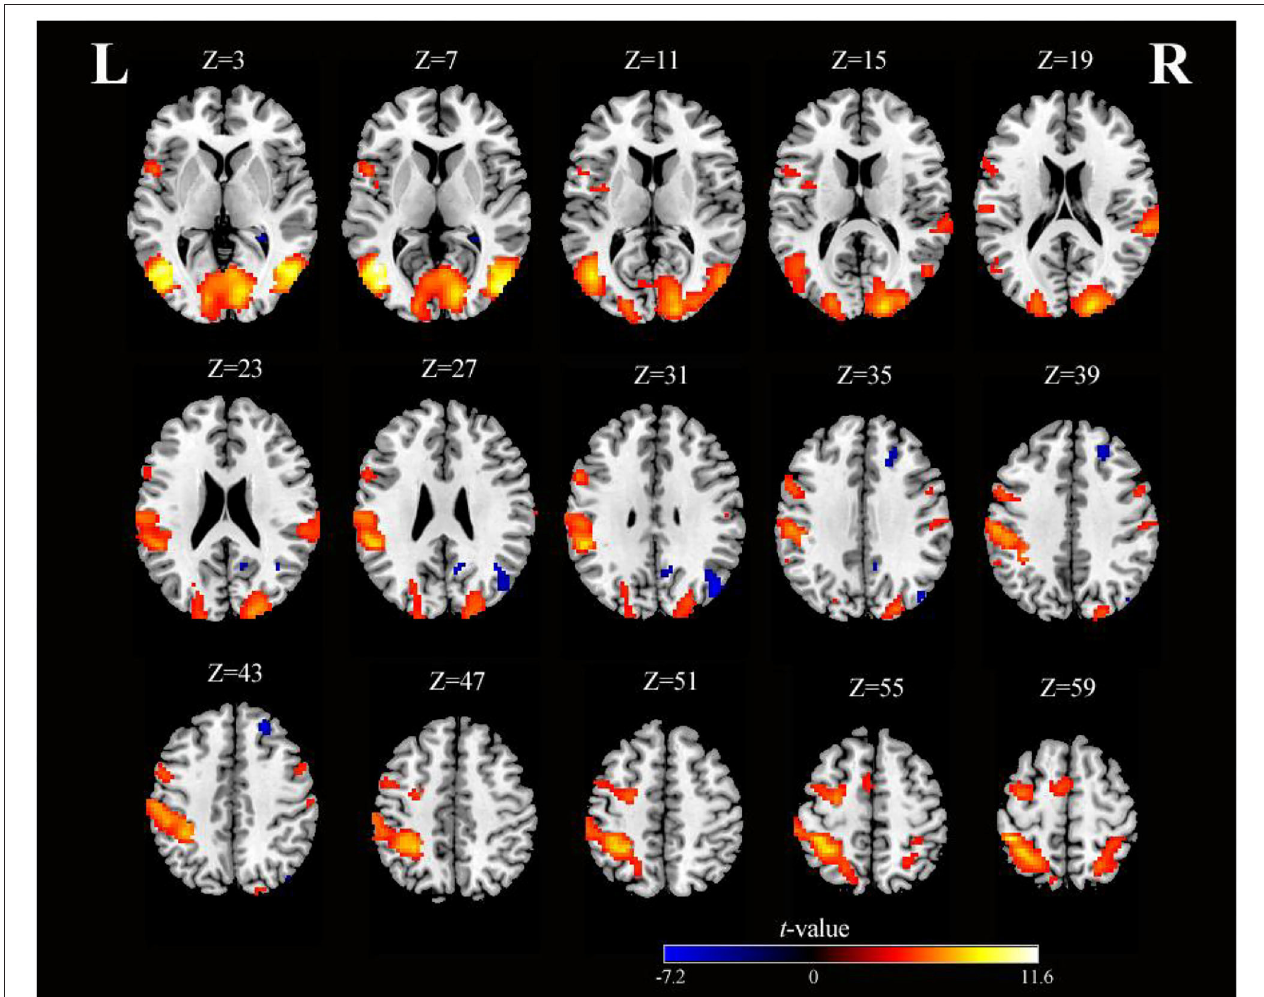
FIGURE 2 | Axial slices with corresponding Z -coordinates (MNI) from the t -value map of SO (voxel-level, FDR-corrected p < 0.001, cluster size > 10 voxels). MNI, Montreal Neurological Institute; SO, sensory observation; FDR, false discovery rate; L, left; R, right .